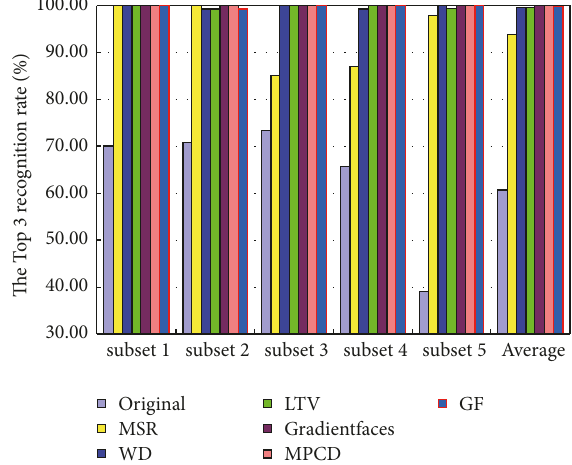
Figure 10: Comparisons on the Top 3 recognition rate (the subset 𝑟 used as the training set).